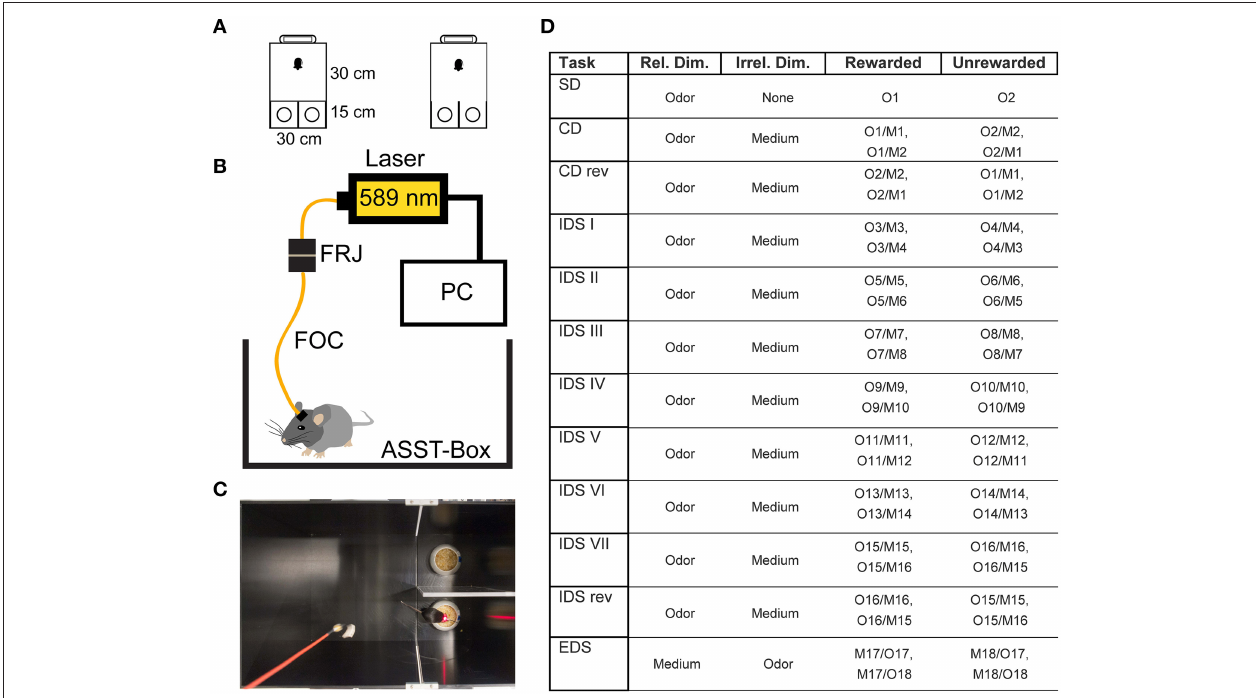
FIGURE 1 | Experimental Setup. (A) Size and shape of the ASST box. The mouse was placed in the waiting compartment, the door was removed and the mouse allowed access to choice compartments. (B) Optical Setup. The mouse was connected to a fiber optic cable (FOC) that was connected to a fiber optic rotary joint (FRJ). Light was generated by a PC-controlled laser. (C) Example image of mouse in the box during control light illumination. (D) Table of odors and materials used for the different stages of the ASST: M1and2: wood pellets of different size, M3and4: aluminum foil pellets of different size, M5and6: cat litter of different size, M7and8: bark mulch of different size, M9and10: silica gel of different size, M11and12: plastic pellets of different size, M13and14: nuts and bolts, M15and16: metal shucks of different size, M17and18: gum Arabic of different size. Different olfactory stimuli were offered by various sweet dried herbs: O1, oregano; O2, parsley; O3, marjoram; O4, basil; O5, rosemary; O6, dill; O7, whitethorn; O8, stinging nettle; O9, lemon balm; O10, thyme; O11, ribgrass; O12, chamomile; O13, chives; O14, savory; O15, yarrow; O16, lime; O17, fennel; O18, mint.